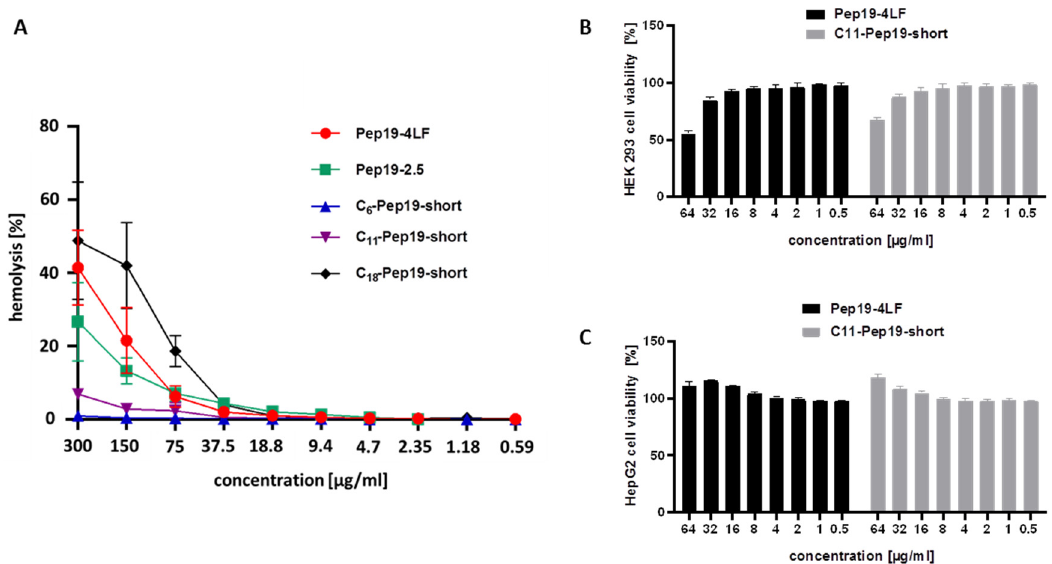
Figure 3 . ( A ) Hemolysis study for Pep19-4LF, Pep19-2.5, C6-Pep19-short, C11-Pep19-short, and